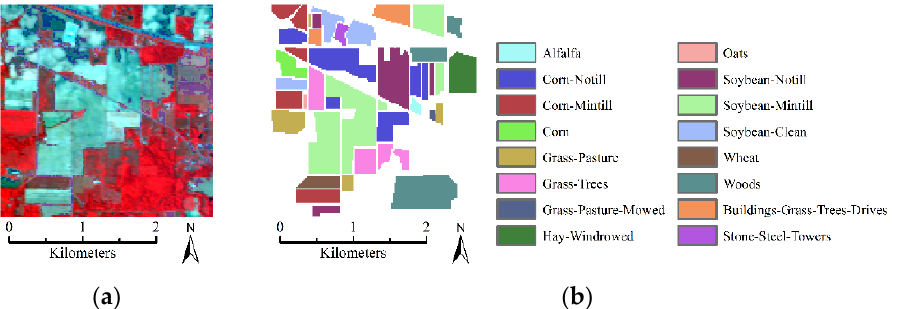
Figure 5. ( a ) The false color composition image of Indian Pines dataset; and, ( b ) the ground truth map of Indian Pines dataset.